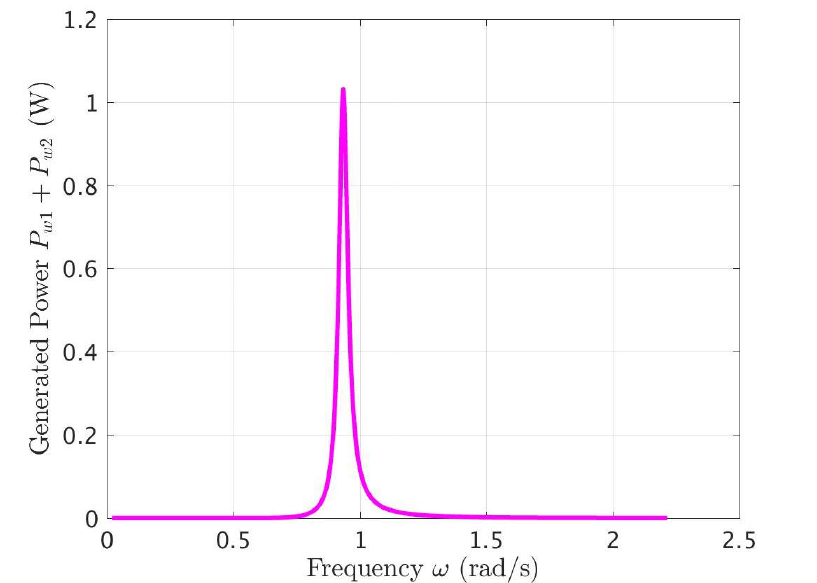
Figure 12. Combined power conversion by Galfenol strips on each beam in response to an irregular wave spectrum (Pierson–Moskowitz, H s = 1.0 m, T e = 5.0 s). Beams fit the deck support